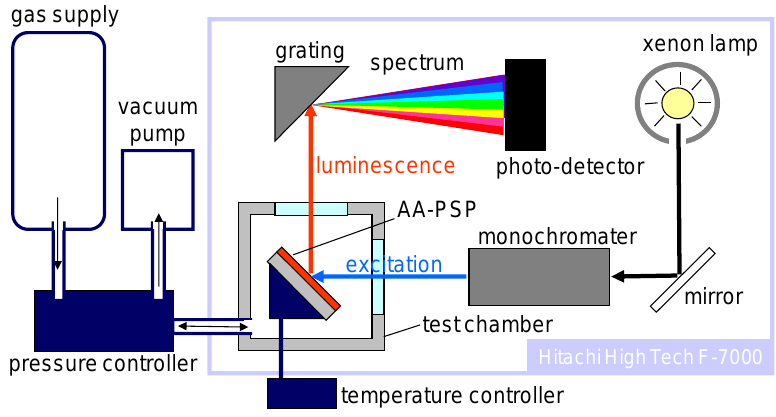
Figure 4. Schematic of AA-PSP calibration